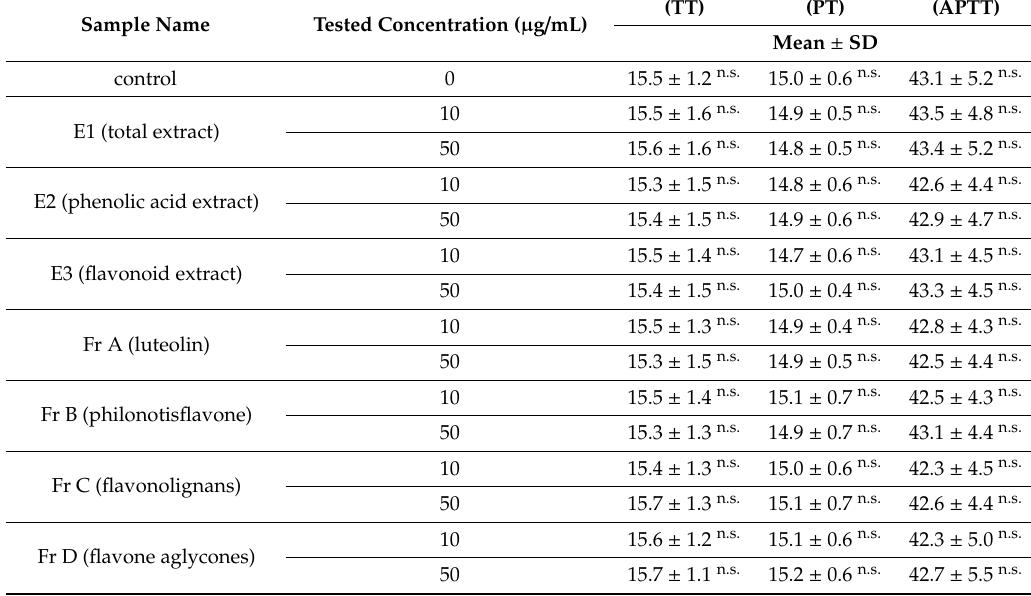
Table 4. E ff ects of extracts (E1–E3) and flavonoid fractions (A–D) of dandelion fruits (concentrations 10 and 50 µ g / mL) on the coagulation times of human plasma (APTT, PT, and TT). Data are presented as means ± SD ( n = 10).